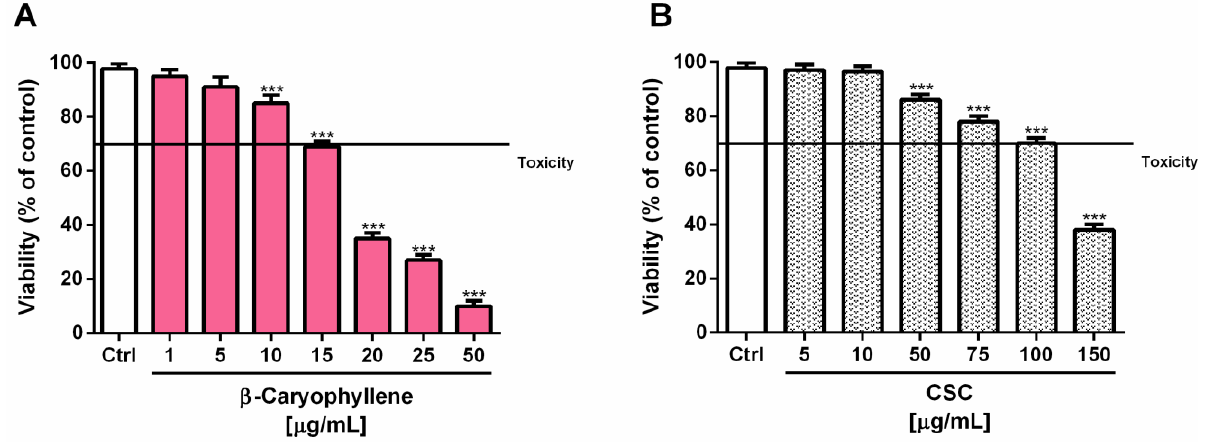
Figure 4. Cytotoxic effects of β -caryophyllene ( A ) and cigarette smoke condensate (CSC; B) in triple- negative breast cancer MDA-MB-468 cells after 24 h exposure. Data are displayed as mean ± SE of at least three independent experiments with at least three technical replicates ( n = 9). *** p < 0.001, significant lowering of cell viability with respect to the control (ANOVA + Dunnett’s multiple comparison post-hoc test).